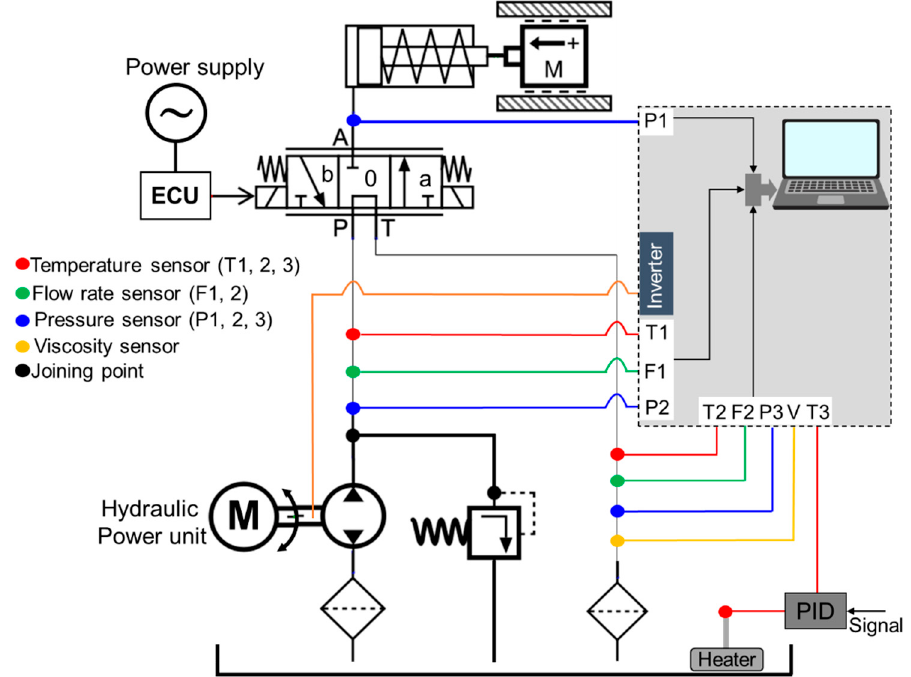
Figure 8. The scheme of the proportional valve test. Table 2. The specifications of the equipment and sensors used in this